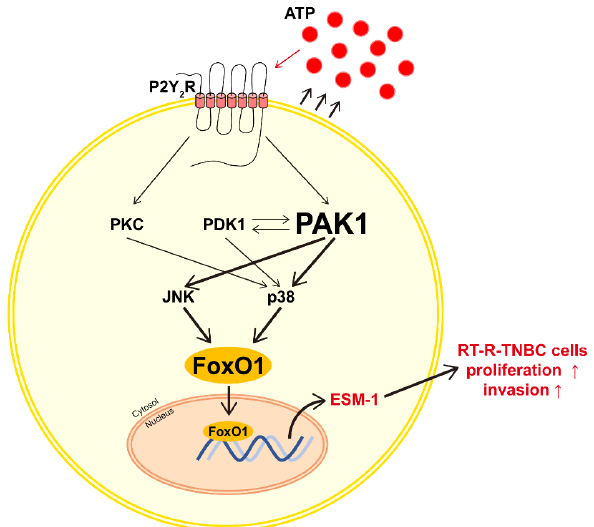
Figure 8. Schematic representation of the proposed mechanism of ESM-1 expression in RT-R-TNBC cells. Supplementary Materials: The following supporting information can be downloaded at: www.mdpi.com/xxx/s1, Figure S1: The original Western blot images for Figure 1; Figure S2: The original Western blot images for Figure 2; Figure S3: The original Western blot images for Figure 3.; Figure S4: The original Western blot images for Figure 4; Figure S5: The original Western blot images for Figure 5; Figure S6: The original Western blot images for Figure 6; Figure S7: A2AR and A2BR siRNA did not affect ESM-1 expression levels; Figure S8: The original Western blot images for Figure 7.